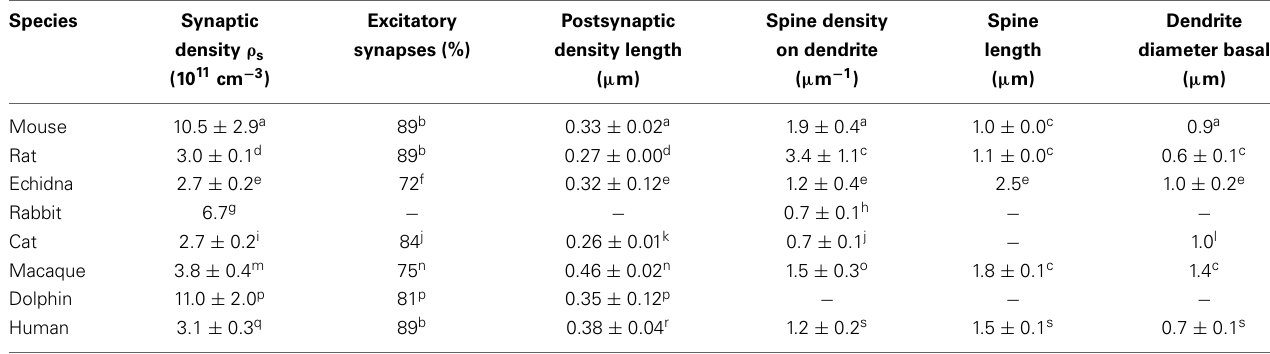
Table 1 | Synaptic and wiring characteristics for mammalian cerebral cortex.